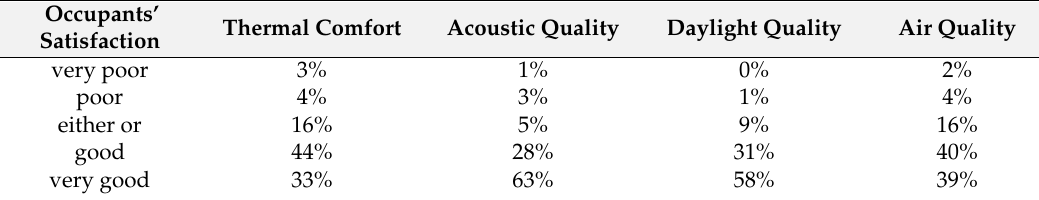
Table 5. Distribution of satisfaction level: general satisfaction with apartment and satisfaction with IEQ (thermal comfort, acoustic quality, daylight quality and air